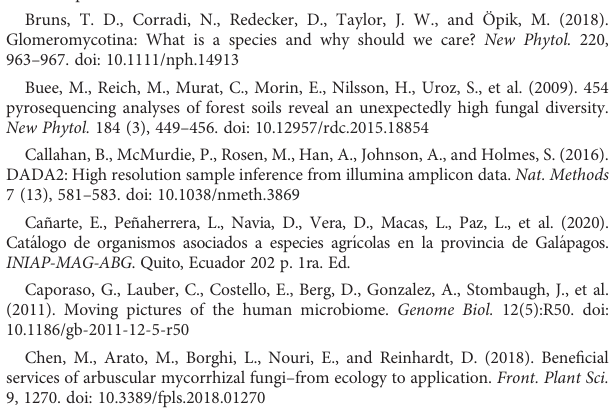
SUPPLEMENTARY FIGURE 2 ITSsequencing ofrhizosphere soil samples of juvenile Inga plants collected in varzea (V) and terra fi rme (TF) ecosystems. Taxa bar plot representing ASVs of all eukaryotic microorganisms ampli fi ed by